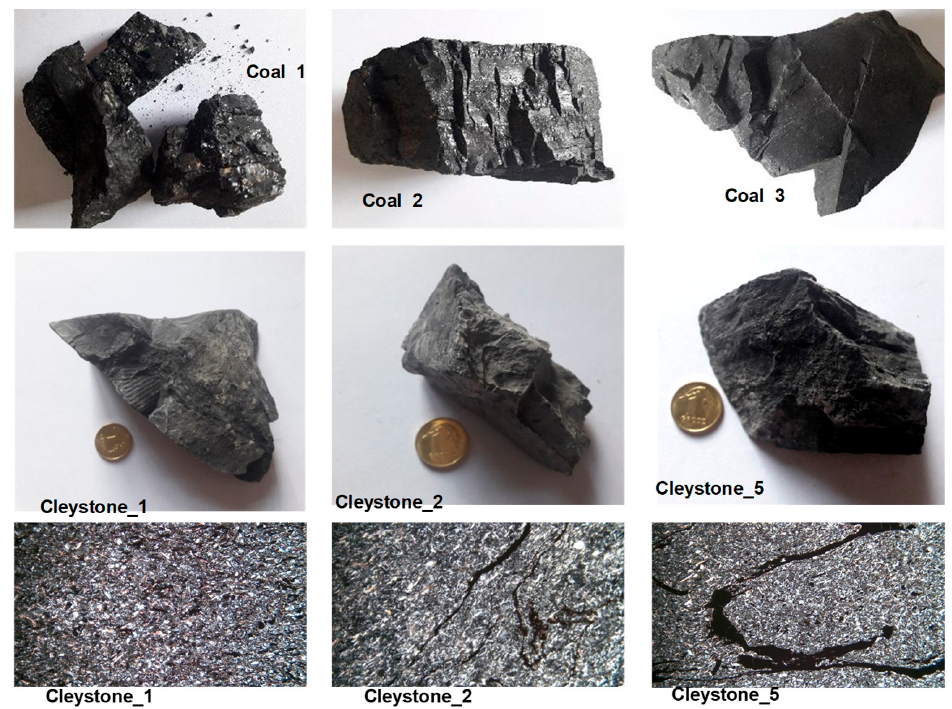
Figure 3. Samples (rows 1 and 2) and microstructure (row 3) of the selected coals and claystones.